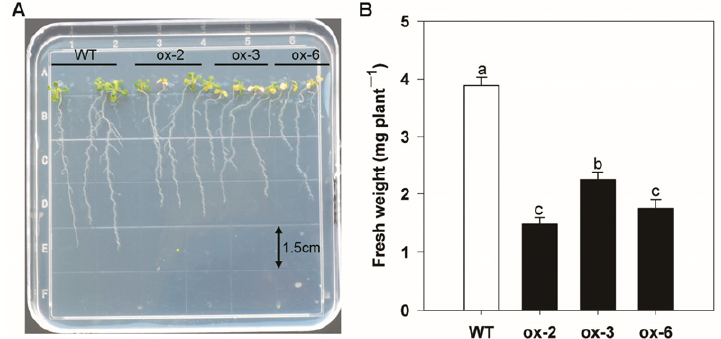
Figure 10. The growth phenotype and fresh weight of the whole plants of overexpressing BcAMT1;5 on NH 4+ toxic analog methylammonium (MeA). ( A ) Growth of wild-type and transgenic lines (line 2, 3, 6) on agarose containing 20 mmol L − 1 MeA for 10 d after being precultured 4 mmol L − 1 NO 3 − for 4 d. ( B ) Fresh weight of the same plants as shown in ( A ). WT: wild-type, ox-2, ox-3, and ox-6 present the line 2, 3, and 6 of overexpressing BcAMT1;5 , respectively. Bars indicate mean ± SE ( n = 10), and different letters above the bars indicate significant differences at p < 0.05.